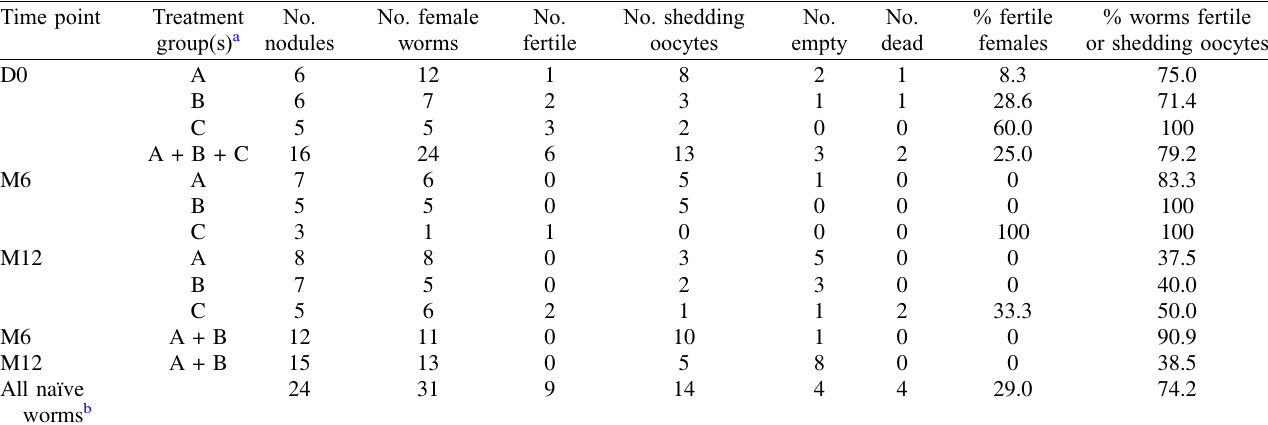
Table 4. Results of the histological examination of nodules. Time point